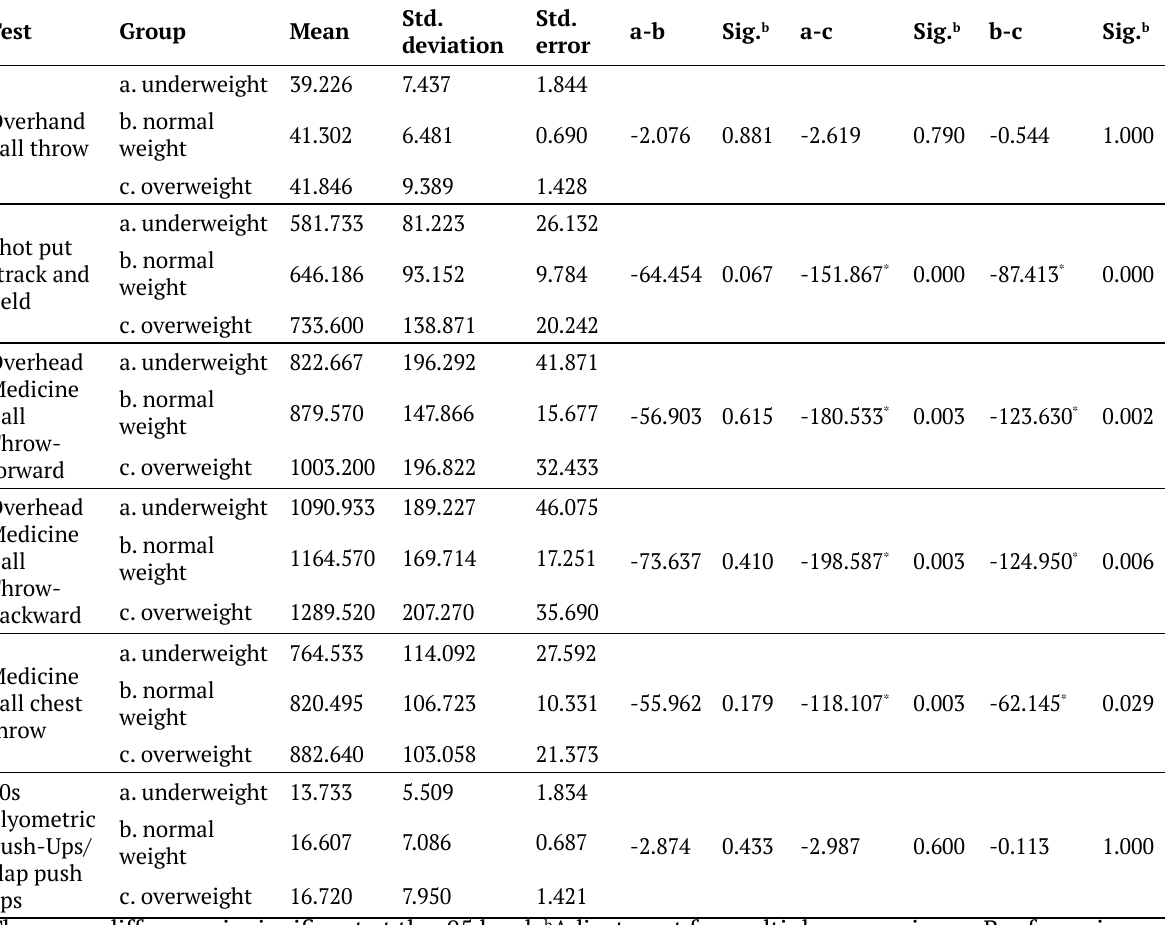
Table 6. Synthesis of average values and differences obtained between the 3 BMI categories for upper body explosive strength (underweight=15, normal weight=107,